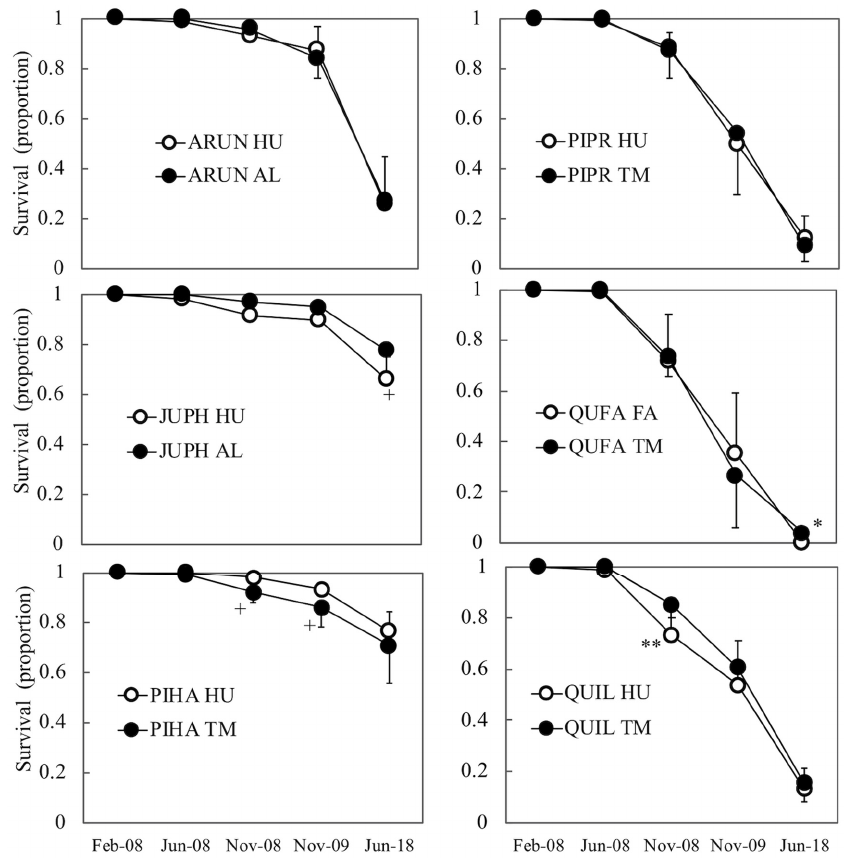
Figure 3. Mean values of field survival for both stocklots in a species throughout the 10-year period studied. In 2008 (planting year), both the spring (June) and the post-summer (November) values are shown. In a species, asterisks (or + sign) mean significant differences between both stocklots in that assessment (+: p ≤ 0.1, *: p ≤ 0.05, **: p ≤ 0.01). Bars correspond to standard deviations. See Table 1 for abbreviations.